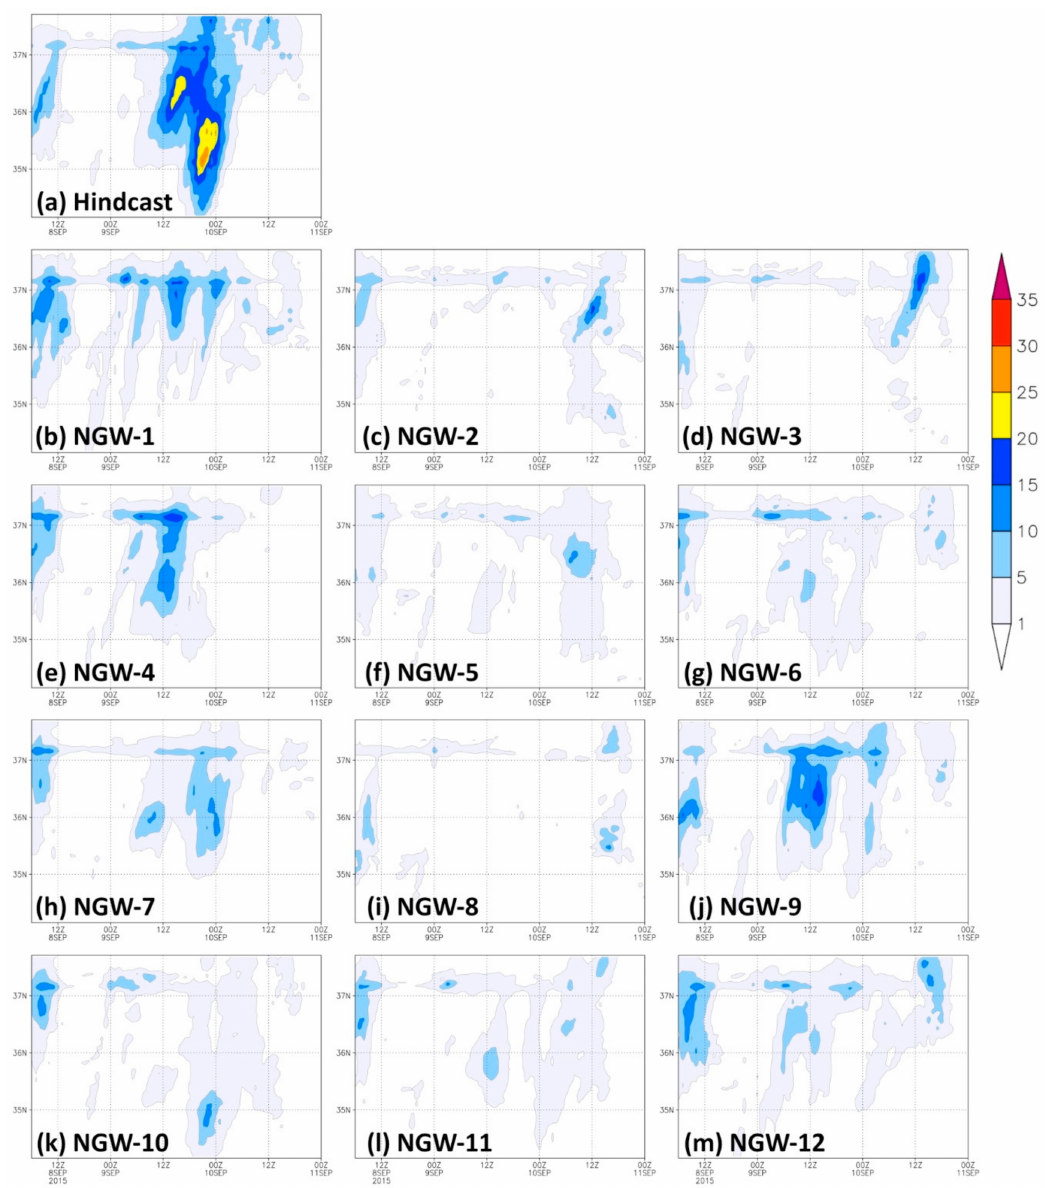
Figure 7. Latitude-time cross section of hourly rainfall averaged for the 139.9 ◦ E–140.1 ◦ E band. Ensemble mean values are shown for each panel. Result of ( a ) hindcastm, ( b ) NGW-1, ( c ) NGW-2, ( d ) NGW-3, ( e ) NGW-4, ( f ) NGW-5, ( g ) NGW-6, ( h ) NGW-7, ( i ) NGW-8, ( j ) NGW-9, ( k ) NGW-10, ( l ) NGW-11, ( m ) NGW-12. The unit of the color bar is mm / h. Table 5 is a summary of the total rainfall averaged for D03 (R T,3 ). The mean and the maximum R T,3 by the hindcast ensemble simulation are larger than those in 10 out of 12 NGW simulations. The minimum R T,3 of the hindcast is larger than that in 11 NGW simulations. Figure 8 shows the probability density distribution of R T,3 for the hindcast and NGW simulations. Probability density curves were estimated from the mean value and standard deviation of R T,3 for the hindcast and NGW simulations based on a normal distribution assumption. The results of NGW-2 and NGW-6 indicate a high probability of the total rainfall being larger than the hindcast. The results of NGW-4 and NGW-9 are similar to those of the hindcast. The other 8 NGW simulations indicate a higher probability of rainfall smaller than the hindcast. The results in Table 5 and Figure 8 indicate a high probability of a larger amount of R T,3 under the condition of higher GHG